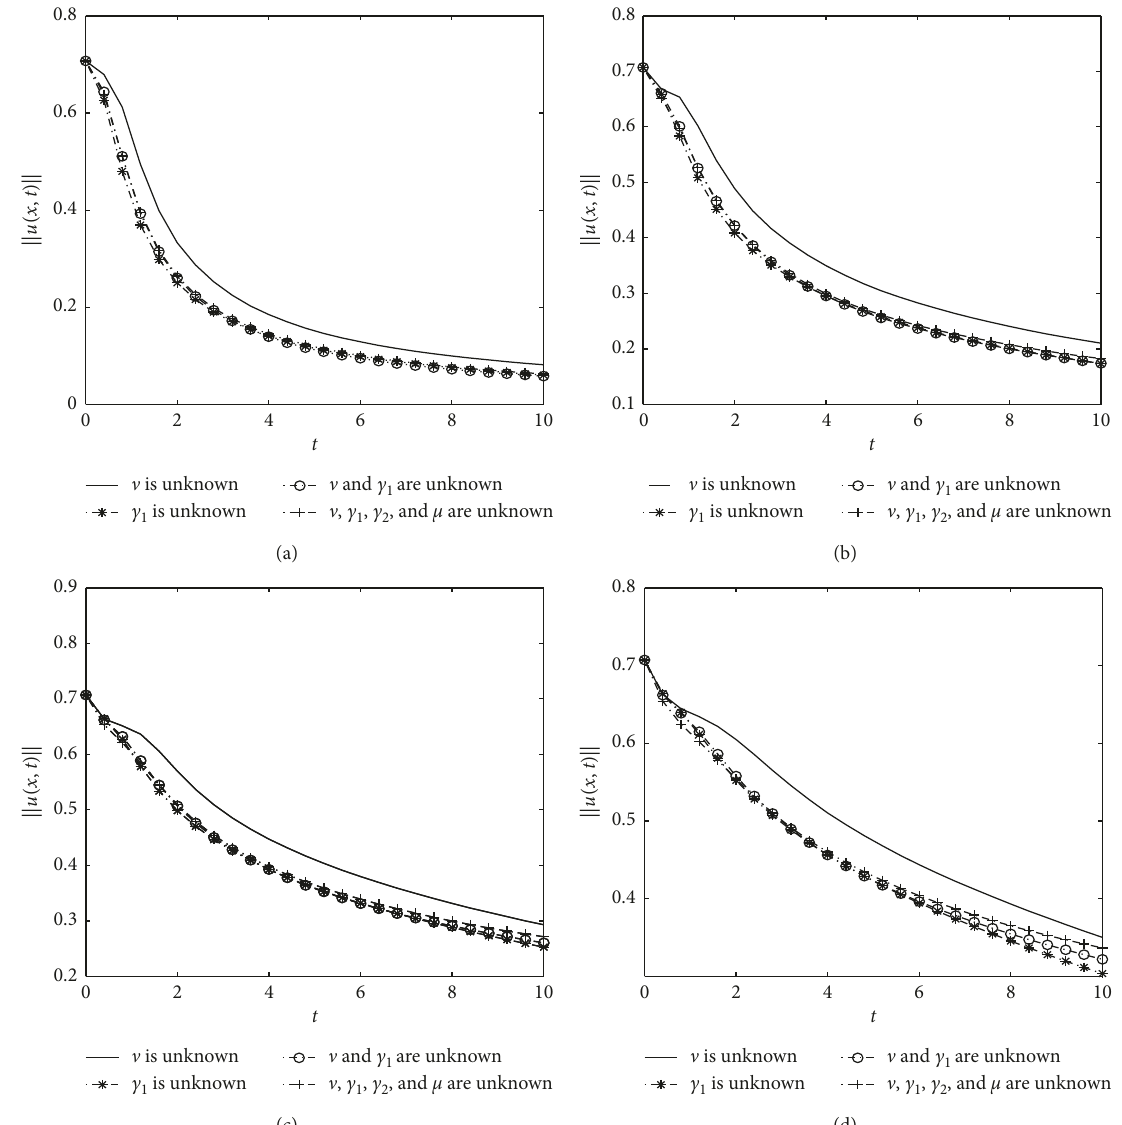
Figure 18: The L 2 -norm of u ( x,t ) , ‖ u ( x,t )‖ , over time for various values of α ; comparison between the behavior of the equation for the ( x ) � sin ( π x ) . (a) α � 1; (b) α � 2; (c) α � 3; (d) α � fourth nonlinear adaptive controller, u 0